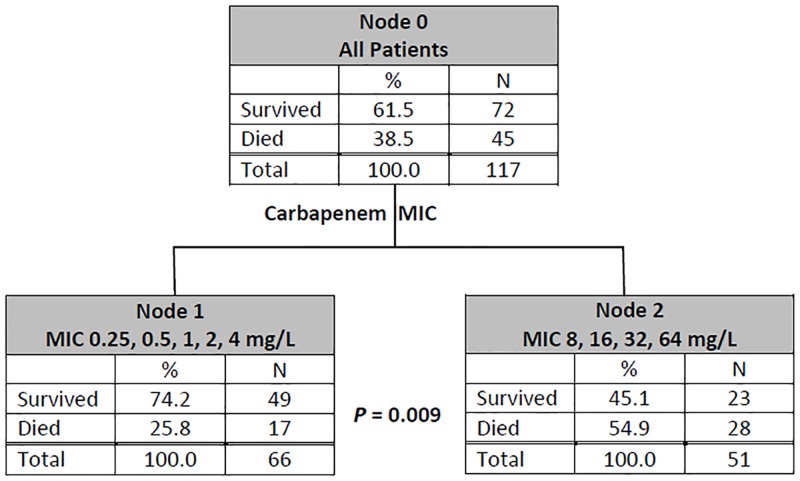
Classification and Regression Tree (CART) analysis determined a split of carbapenem minimal inhibitory concentration (MIC) between 4 and 8 mg/L and predicted differences in mortality.